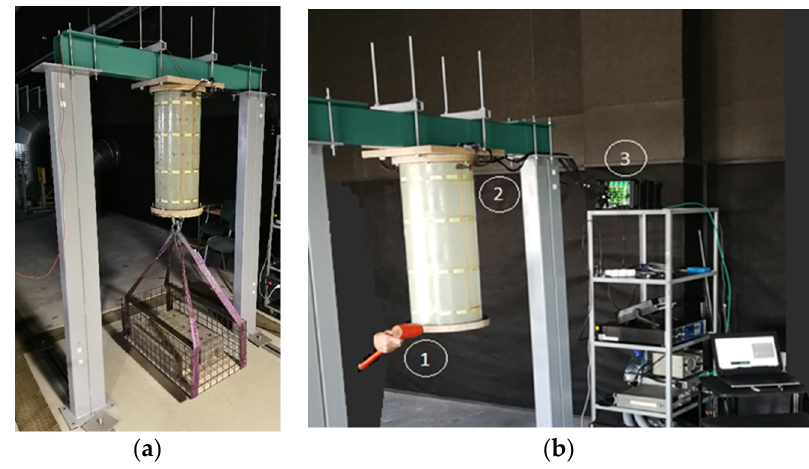
Figure 2. Test setup: ( a ) specimen with suspended weight; ( b ) plastic hammer for actuation. The latter included the 48 channel measurement unit and the laptop with data recording software. The data collected during the test was saved as the file, with identification name. Three tests were used for each load grade.